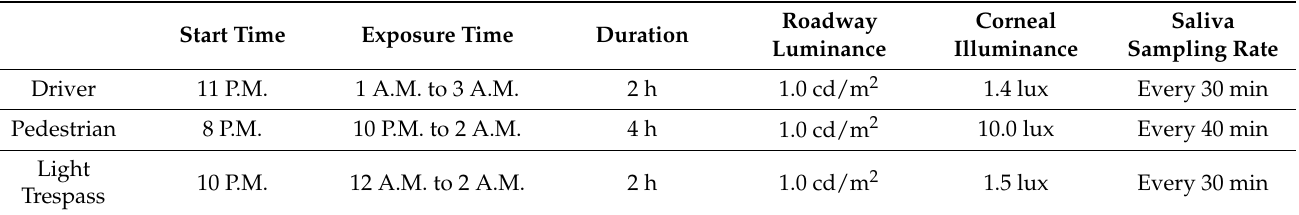
Table 1. Exposure Conditions based on Experiment Type.